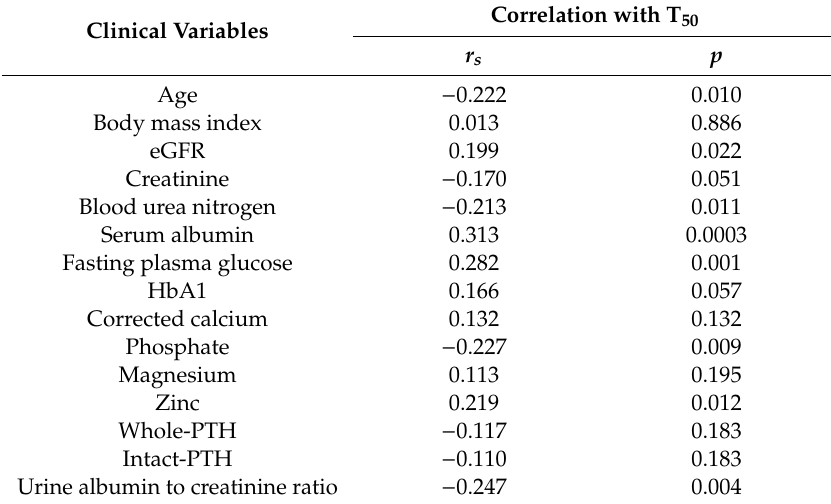
Table 2. Correlation of serum T 50 with clinical factors in diabetic patients.